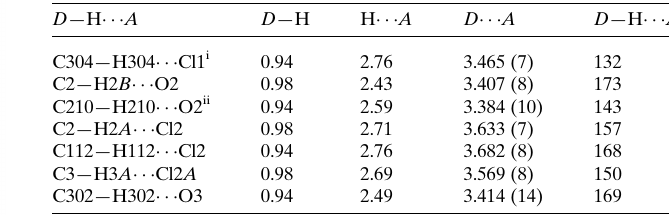
Table 5 Hydrogen-bond geometry (A˚ , (cid:3) ) for 4